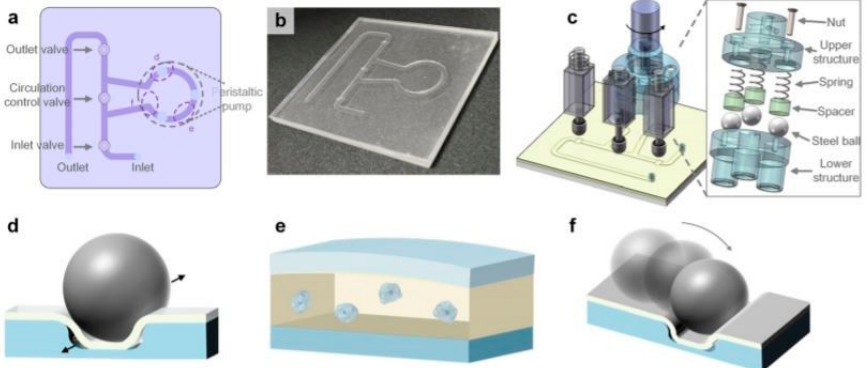
Figure 13. The pump-on-chip cell disruption microfluidic chip utilized in [50]; ( a ) schematic of the device, ( b ) picture of the fabricated cell disruption microfluidic chip. ( c ) Schematic of the platform with the on-chip micropump, electromagnets. ( d ) Cells in the sample leaking through the gap between the channel corners and the PDMS membrane are pulverized by the steel balls. ( e ) The compressive stress makes cells deform. ( f ) Some cells are crushed down by the steel balls. Adapted with permission from [50]. Copyright 2017 AIP Publishing.